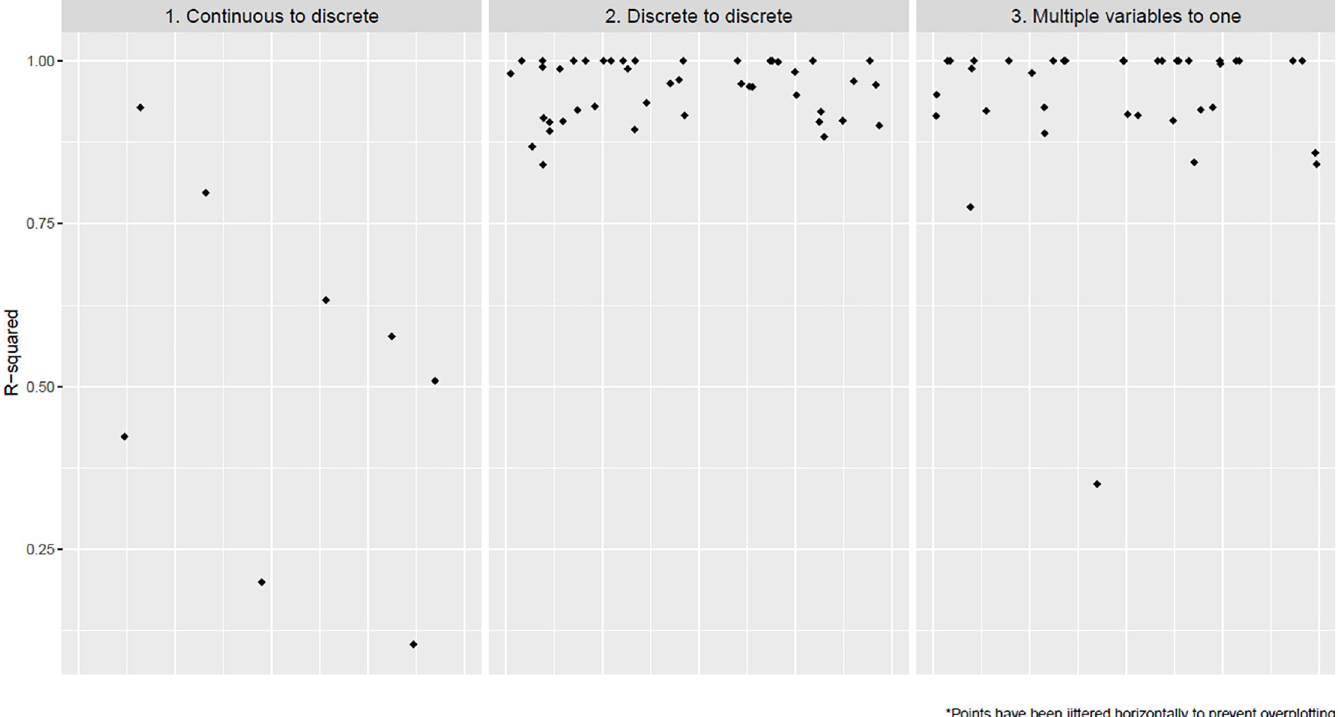
Fig 2. Pooling accuracy for three data recoding categories.